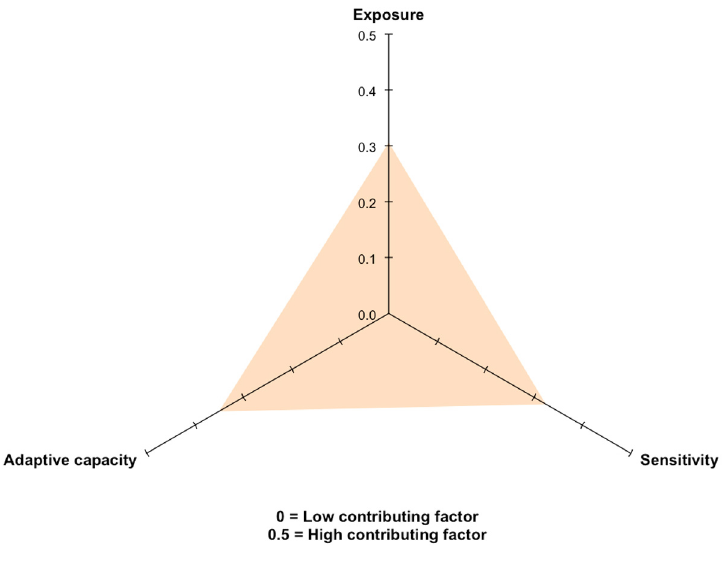
Figure 4. Vulnerability of the main components of the SLA at the municipality of Inhambane